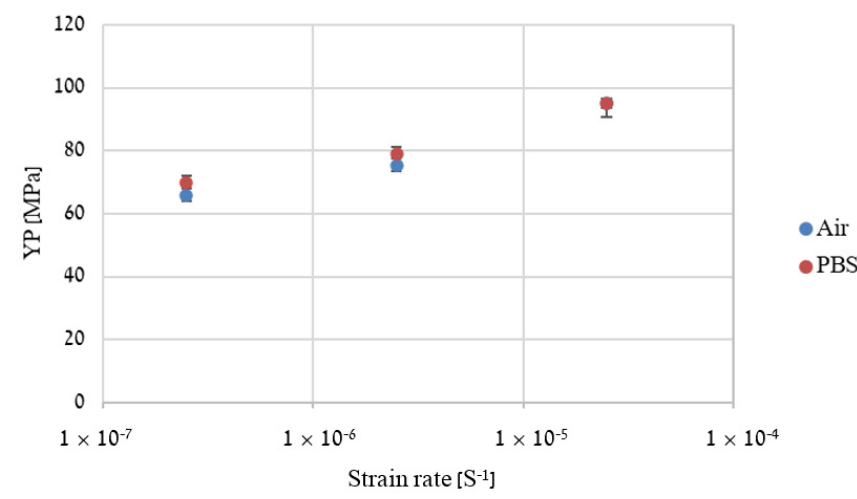
Figure 6. Yield point Vs. strain rate of Zn-2%Fe-0.6%Ca alloy in air and PBS solution.